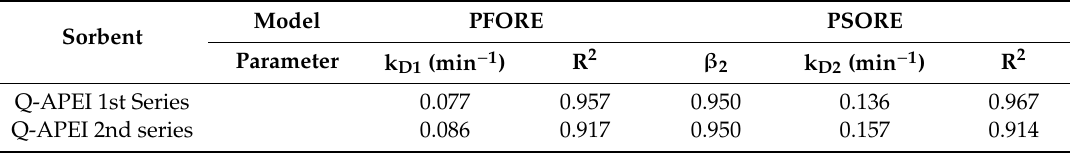
Figure 6. Desorption kinetics for U(VI) loaded on Q-APEI—Modeling with the PFORE and the PSORE for the 1 st series ( a ) and the 2 nd Series ( b ) (samples collected from uptake kinetics; eluent: 0.5 M NaCl / 0.5 M HCl; SD: 0.85 g L − 1 ; agitation speed: 170 rpm; T: 22 ± 2 ◦ C). Table 4. Modeling of kinetic profiles for U(VI) desorption from loaded Q-APEI sorbent—PFORE and PSORE model [86].